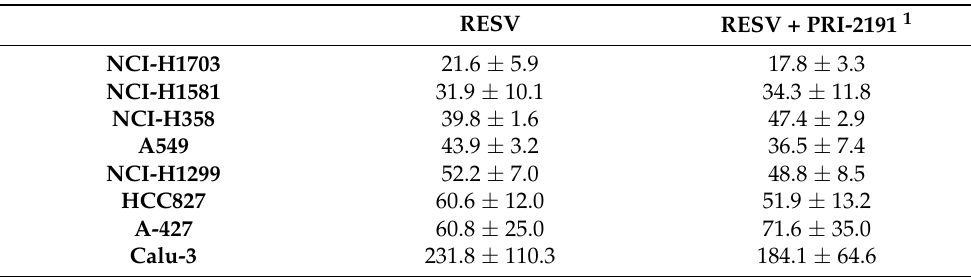
Table 1. Antiproliferative activity of resveratrol (RESV) alone and in combination with (24 R )-1,24- dihydroxycholecalciferol, (24 R )-1,24(OH) 2 D 3 (PRI-2191) on lung cancer cell lines expressed as in- hibitory concentration 50 (IC 50 ).